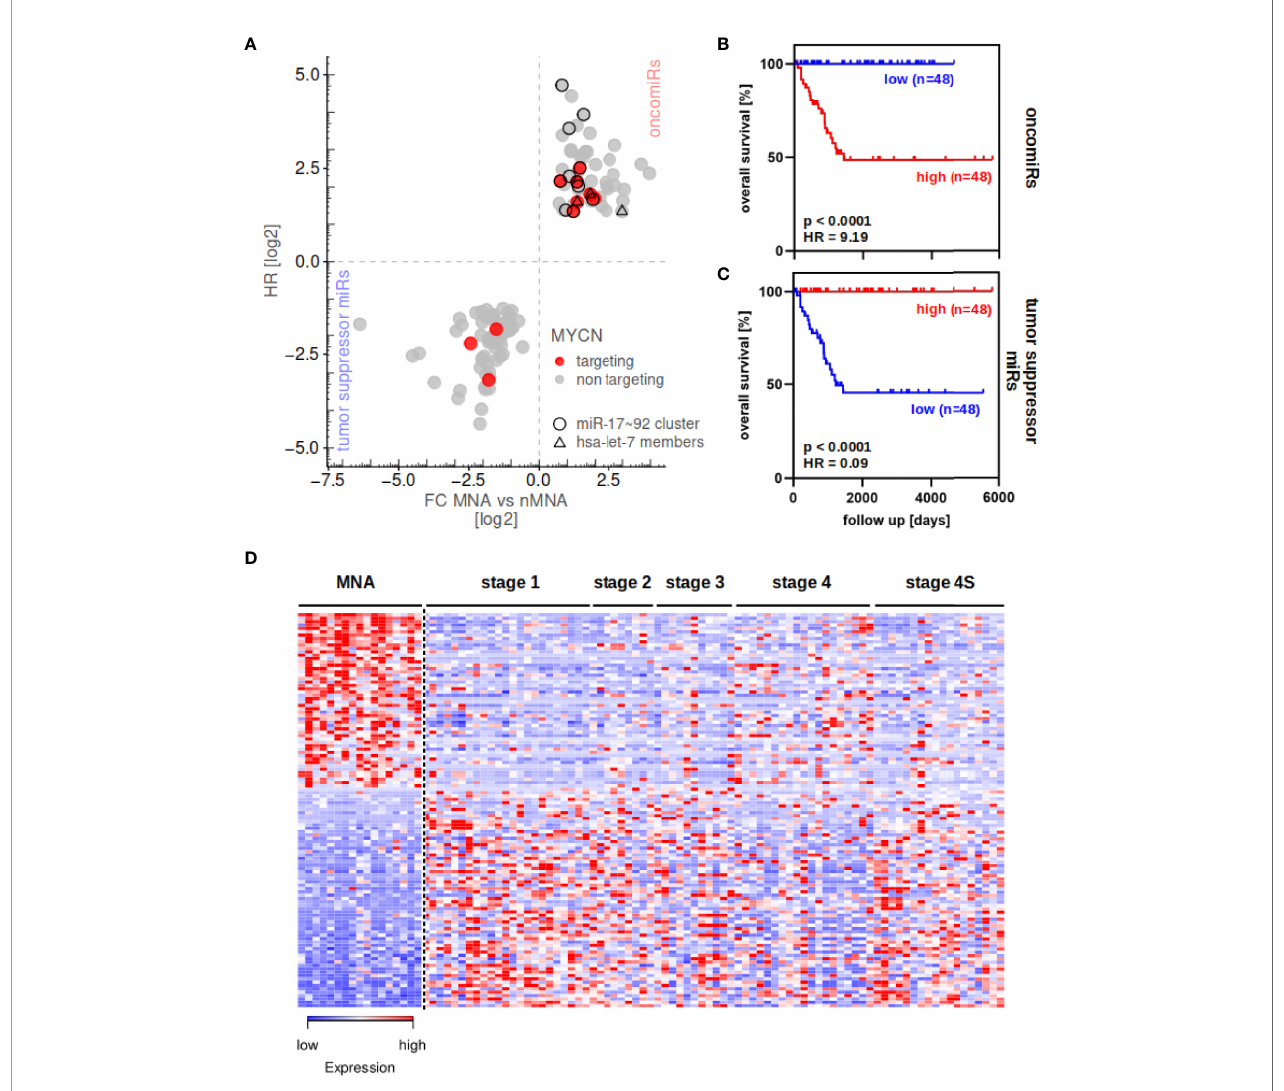
FIGURE 1 | miRNA expression can distinguish between MYCN-ampli fi ed and non-ampli fi ed tumors. (A) Differential miRNA expression analysis in 17 MNA and 80 nMNA neuroblastoma tumors and subsequent determination of hazardous ratio (HR, one sample lack survival data) of these miRNAs revealed 52 oncogenic and 66 tumor suppressive miRNAs (see Supplementary Table 1 for fold changes and HR). MYCN-targeting miRNAs are indicated by colors, members of the miR-17-92 cluster and let-7 family are indicated by circles and triangles, respectively. Survival analysis of upregulated (B) or downregulated (C) miRNA signature show strong association of the respective miRNAs to overall patient survival probability. (D) The 118 differential expressed miRNAs distinguish MNA and nMNA tumors, as indicated by heatmap. Expression values are scaled for individual miRNAs (rows in heatmap). MYCN-ampli fi ed tumors (MNA) as well as clinical staging of nMNA tumors are indicated in the top